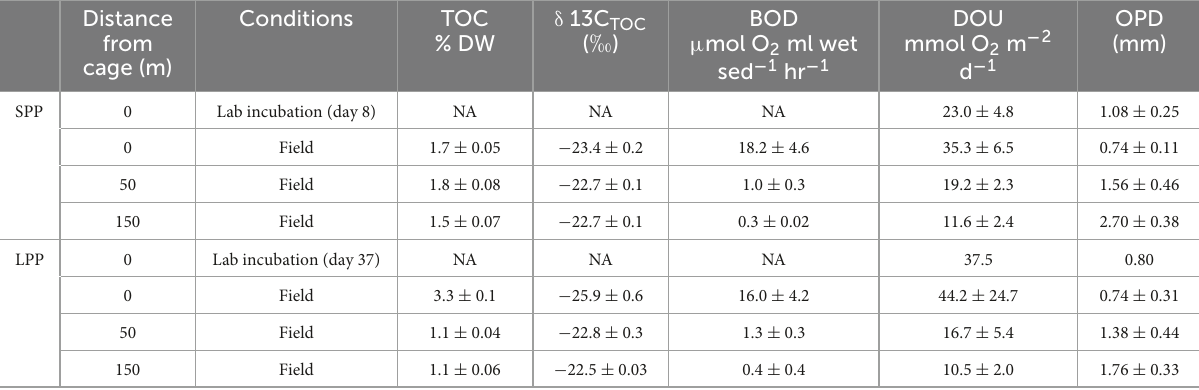
was identified as the main defining factor of the ordination (PC1 = 35%) and differentiated the sediments in two clusters: samples at the fish cages ( Cage ) and samples further away ( ≥ 50 m ) ( Figure 2 ). The deepest sediment layer (3–5 cm depth) from the SPP station at the cage, grouped with the ≥ 50 m sediment samples. ANOSIM analysis confirmed that the microbial communities differed when considering distance from the cage (Cage vs. > 50 m; R = 0.6; significance = 0.001), whereas the production period (LPP vs. SPP) had a less significant effect ( R = 0.4; significance = 0.002). The two PCoA clusters (Cage and ≥ 50 m) were used in a two-way comparison DESeq analysis to identify the microbial taxa that were differentially abundant between the two clusters. DESeq analysis identified 39 differentially abundant taxa for the Cage cluster and 18 taxa for the > 50 m cluster (LFC ≥ |4| and p < 0.01, Supplementary Table 5 and Supplementary Figure 4 ). Of the 39 differentially abundant taxa for the Cage cluster, the taxa with the highest relative abundance belonged to the genera Streptococcus (up to 15.7%), Silanimonas (up to 8.7%), Sulfurimonas (up to 4.0%), Desulfocapsa (up to 1.9%), Thioalbus (up to 1.8%), and two unknown genera from the Saprospiraceae (up to 4.8%) and Sedimenticolaceae (up to 3%) families ( Supplementary Figure 5 ). The most abundant taxa for the > 50 m cluster within the identified 18 differentially abundant taxa were Pseudomonas (up to 3.5%), Sedimentibacter (up to 2.6%), and two unknown genera within the Bacteroidetes vadinHA17 (up to 1.7%) and Prolixibacteraceae (up to 2.3%) families ( Supplementary Figure 5